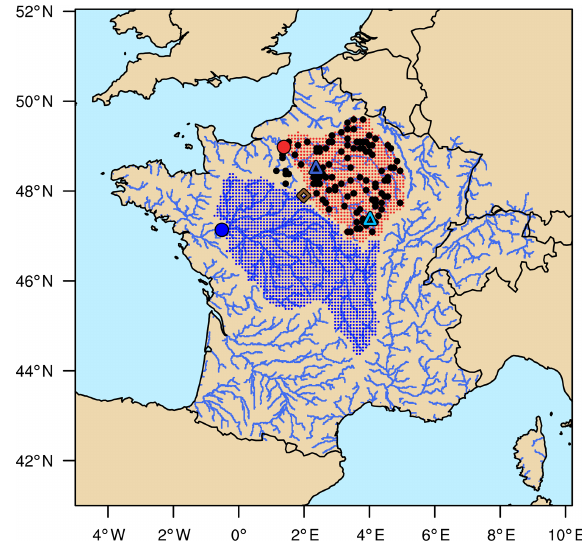
Figure 1. Location of the Seine catchment (red area) correspond- ing to the Seine at Poses station, considered as the outlet (red dot), and of the Loire catchment (blue area) for the Loire at Montjean- sur-Loire station (blue dot). Location of hydrometric stations both observed and simulated (black circles), and of the two long-term river flows observations available: the Paris Austerlitz station (dark blue triangle) and the Aisy-sur-Armançon station (light blue trian- gle). Location of the long-term piezometric level series at Toury (brown